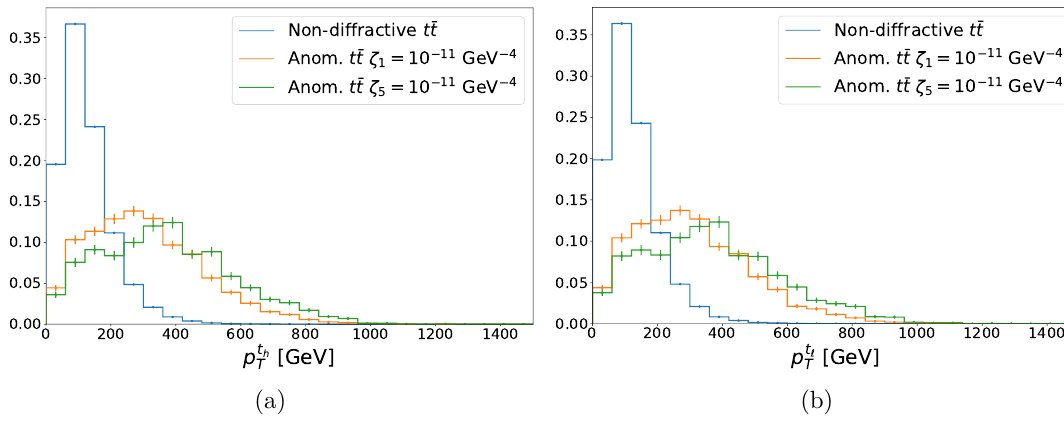
Figure 3. Transverse momentum spectrum, reconstructed from t ¯ t decay products, for the top quark decaying hadronically (a) and leptonically (b). Only events passing the pre-selection are shown. Histograms are normalized to unity.